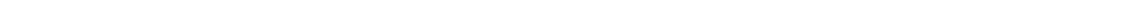
Fig. 10 Rescue of T-cell function by agonist antibodies occurs via activation of alternative MAPK signaling pathways independent of ERK. Ex vivo RNA extraction of trametinib-(1 mg/kg/day) treated 4T1Ch9 or vehicle-treated tumors was undertaken to perform Affymetrix microarray analysis. a Heat map representing upregulated and downregulated differentially expressed genes between vehicle- and MEKi-treated 4T1Ch9 tumors (duplicates/condition) based on adjusted P -value of < 0.05. Hierarchical clustering was performed. b Mouse and human T-cell signaling was analyzed using puri fi ed CD8 + mouse T cells isolated from mouse spleen and activated for 16 h with α -CD3 (1 µ g/ml) antibody. Treatment groups include: unstimulated or stimulation with α -CD3/CD28 antibody (0.5 µ g/ml in mouse), trametinib (10 nM), α -4-1BB (50 µ g/ml) or α -OX-40 (50 µ g/ml) antibody alone, or combination of trametinib and agonist antibody for an incubation period of 72 h. Human T-cell signaling was analyzed using puri fi ed CD45RA + CD8 + human T cells isolated from human PBMCs and activated for 16 h with α -CD3 (OKT3; 1 µ g/ml) antibody. Treatment groups were as above, dosed for an incubation period of 5 min. b Western blot analysis was performed for phosphorylated proteins of T-cell signaling pathways; p-ERK (42/44k Da), p-p38 (43 kDa), p-MKK3/6 (38/40kDa), p-MKK4 (44 kDa), p-AKT (60 kDa), p-JNK (54 kDa), c-JUN (48 kDa), p-NF к B (65 kDa), and GAPDH (40 kDa). c Western blot quantitation based on relative density, normalized to untreated control. d CBA analysis of IFN γ production by α -CD3/CD28 antibody- (1 or 0.5 µ g/ml) activated mouse CD4 and CD8 T cells following MEKi (100 nM) and agonist rescue (50 µ g/ml) with inhibition of JNK and P38 pathways using P38 inhibitor (10 µ M) and JNK inhibitor (10 µ M) following 72 h of treatment. Experiment was performed in quadruplicate and is